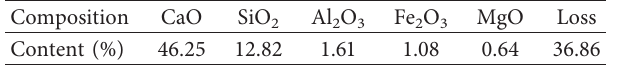
Table 5: Lime powder chemical composition.